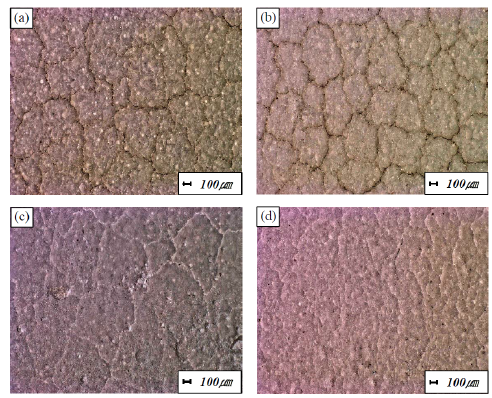
Figure 6. High-resolution optical micrographs of the surface of the EBCs after the thermal shock test at 1350 °C: ( a ) mullite, 100 cycles; ( b ) mullite + Yb 2 SiO 5 , 100 cycles; ( c ) mullite, 5000 cycles; and ( d ) mullite + Yb 2 SiO 5 , 5000 cycles.